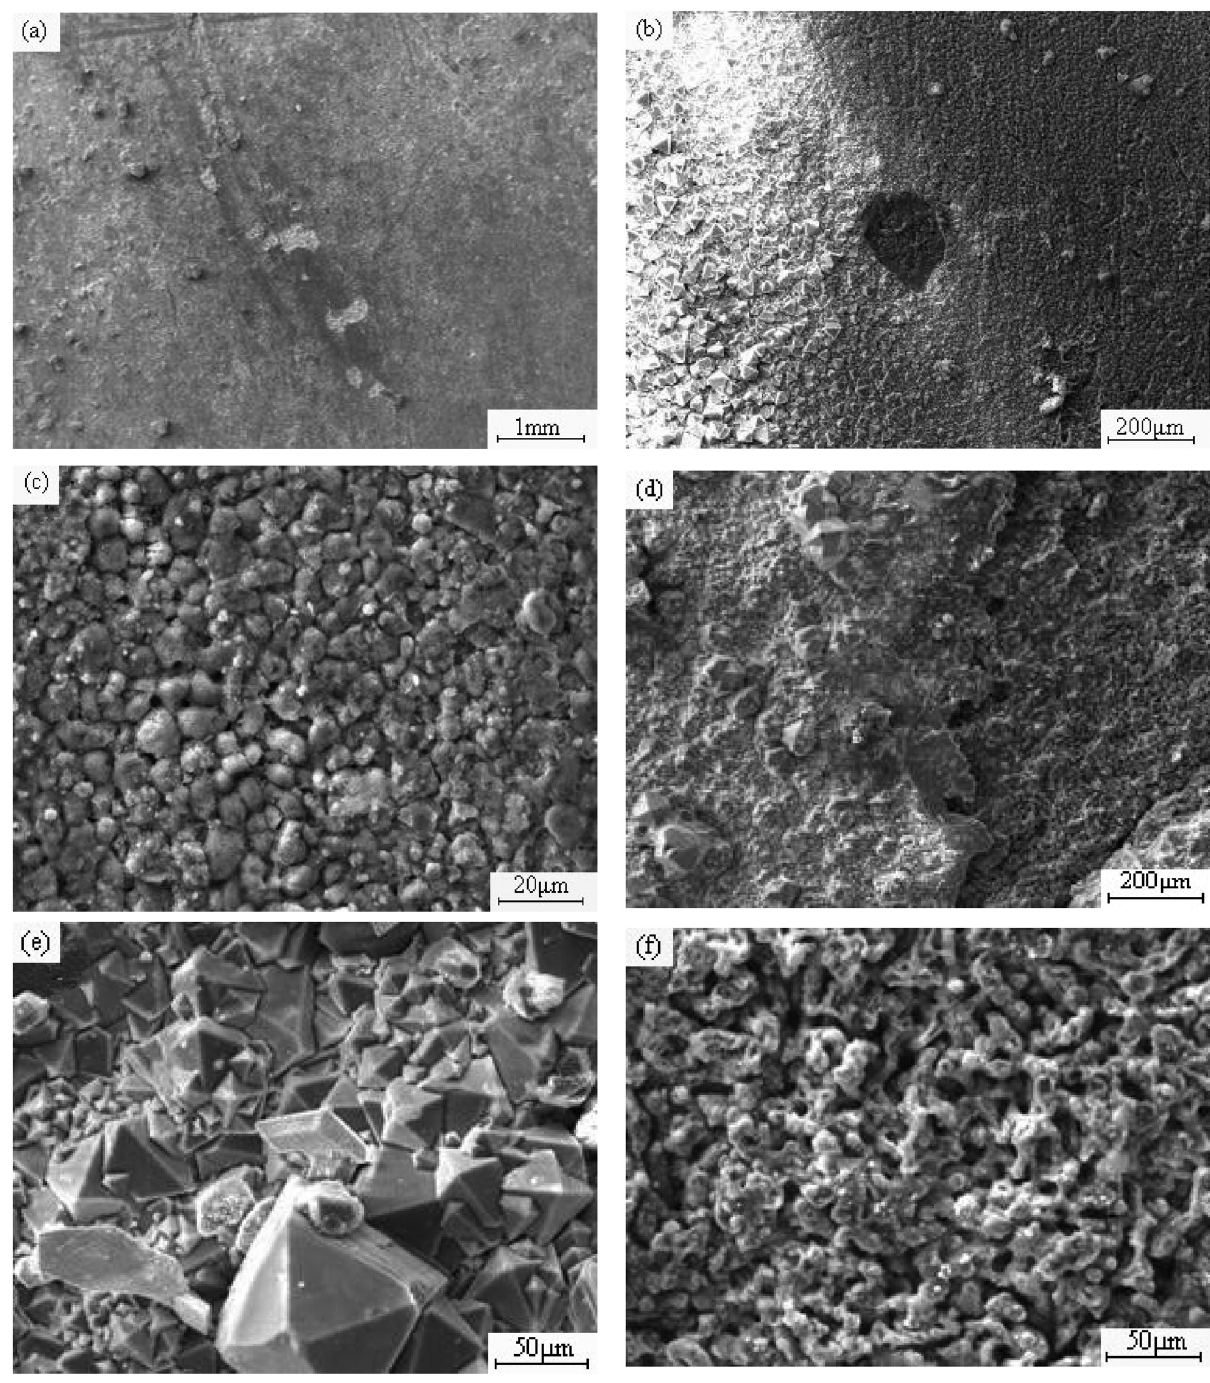
Figure 2: 316 ss surface morphology after corrosion in ternary chloride molten salt at 700°C ( a – c ) , 900°C and ( d – f ) for 60